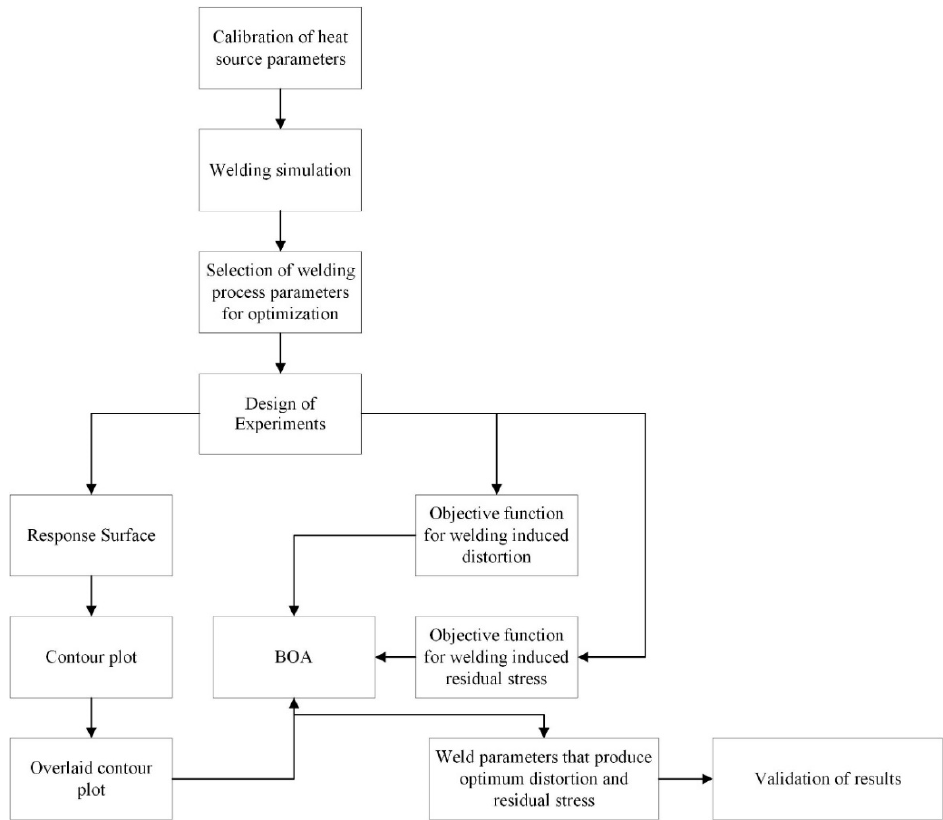
Figure 1. The framework of the multi-objective optimization study .